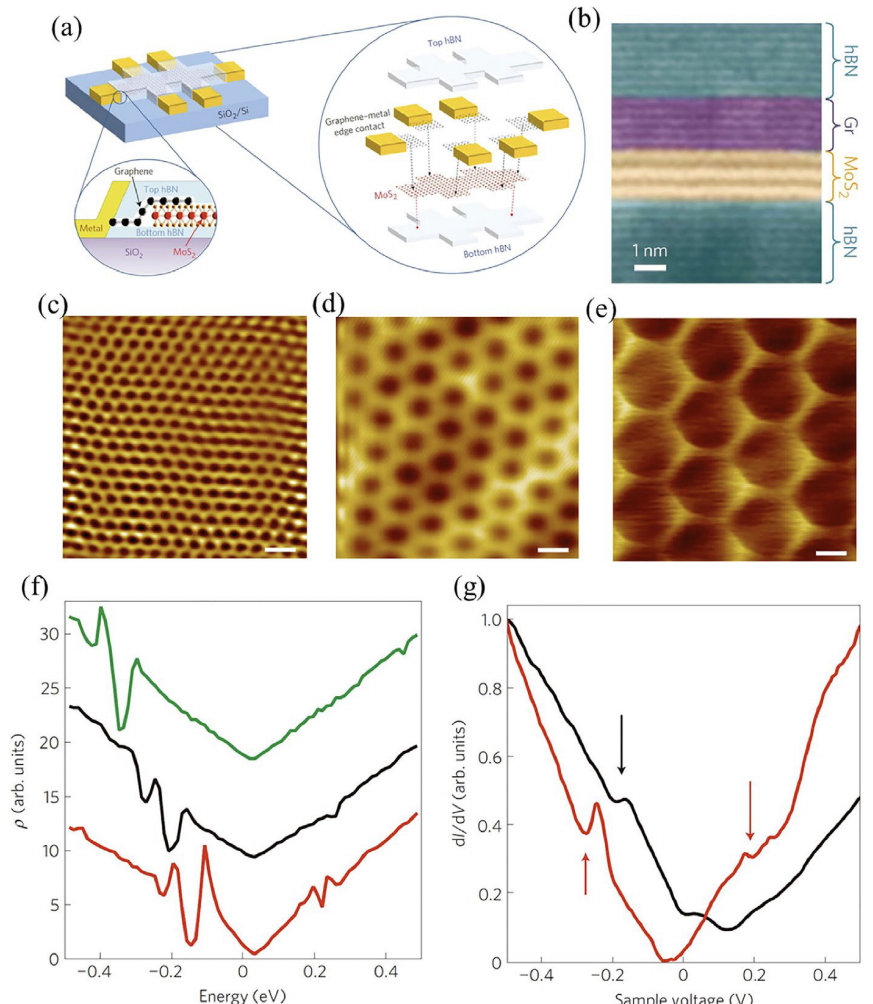
Figure 3. ( a ) Schematic depiction of MoS 2 -based multi-terminal device encapsulated with h -BN. ( b ) False-color cross-sectional STEM images of the fabricated device. Adapted with permission from Ref. [77]. Copyright 2015, Nature Publishing Group. STM topography images with moir é patterns at ( c ) 2.4 nm, ( d ) 6.0 nm, and ( e ) 11.5 nm. The scale bar is 5 nm. ( f ) A theoretical low density of state behavior at three distinct rotation angles between graphene and h -BN, where green, blue, and red represent 6.3 nm, 10.0 nm, and 12.5 nm, respectively. ( g ) Experimental dI/dV behavior at distinct moir é wavelengths of 13.4 nm (red) and 9.0 nm (black) and the arrows indicate dips in the dI/dV curves. Adapted with permission from Ref. [79]. Copyright 2012, Nature Publishing